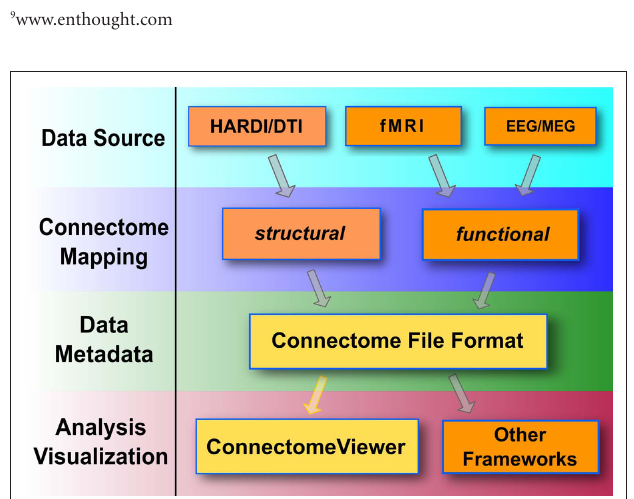
Figure 2 | The Connectome File Format Container. The connectome objects with reference to their primary data and metadata are depicted as small boxes. They are stored in a connectome file, represented by the open big box. After data manipulation, the connectome file can be compressed and shared with collaborators or sent to